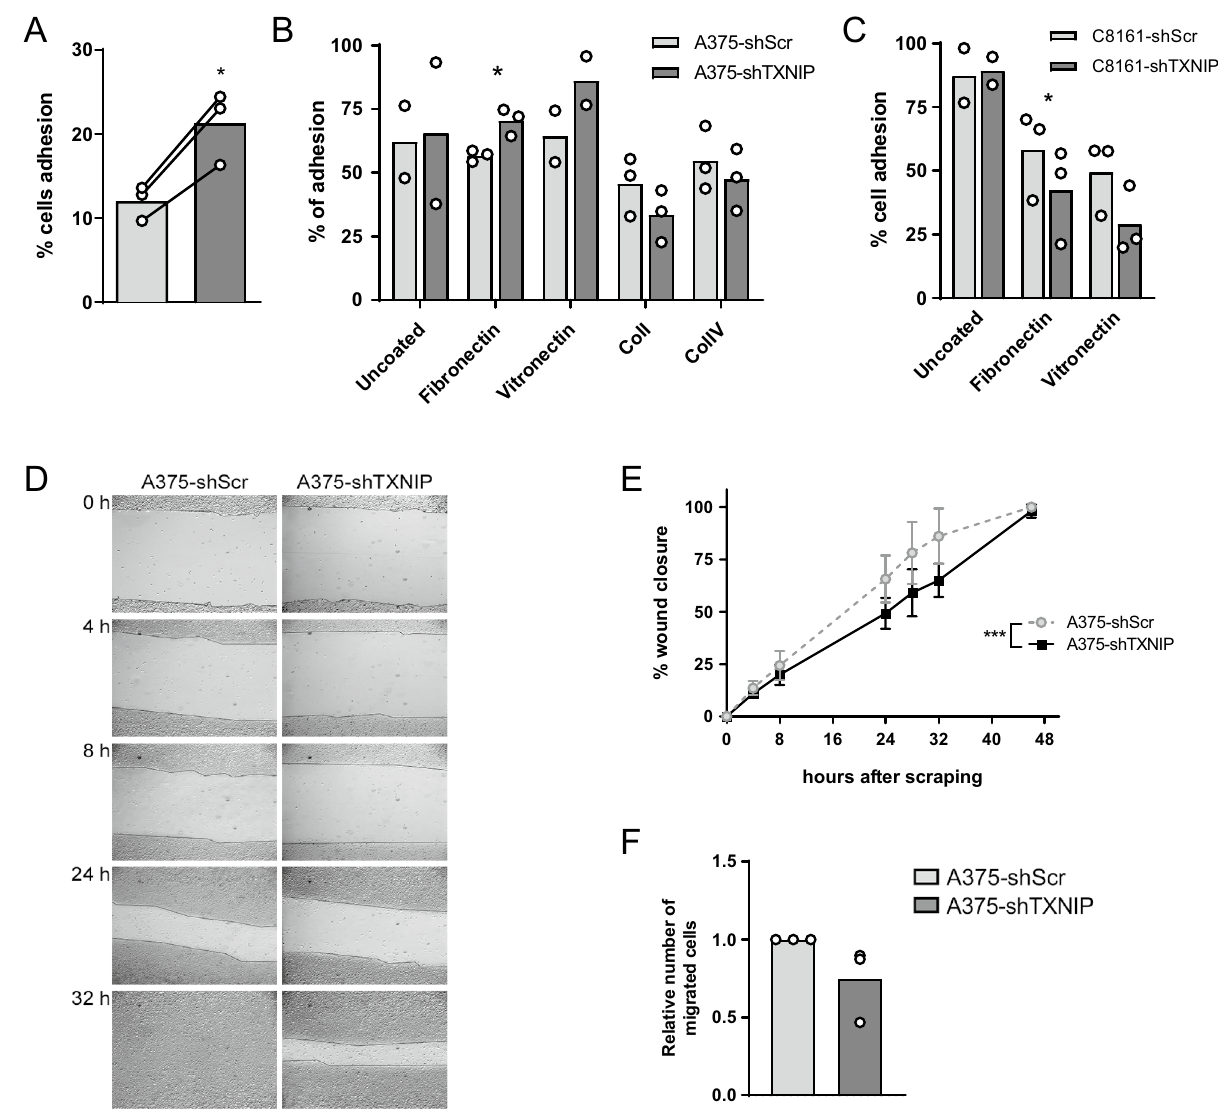
Figure 5. TXNIP silencing affects melanoma cell adhesion and migration. (A) Trypsin resistance assays of A375-shScr and A375-shTXNIP cells. Each open circle represents one independent experiment with biological triplicates (n = 3). Columns are means of three independent experiments (N = 3). Statistics: paired Student’s t-test. (B) Adhesion assays of A375-shScr and A375-shTXNIP cells on various ECM protein coatings, as indicated. Each open circle represents one independent experiment with biological triplicates (n = 3). Except for Uncoated and Vitronectin treatments (N = 2), three independent experiments were performed (N = 3). Columns are means of two to three independent experiments. Statistics: paired Student’s t-test. (C) Adhesion assays of C8161-shScr and C8161-shTXNIP cells on various ECM protein coatings, as indicated. Each open circle represents one independent experiment with biological triplicates (n = 3). Columns are means of two to three independent experiments (N = 3). Statistics: paired Student’s t-test. (D) A375-shScr and A375-shTXNIP cell monolayer scraping assays. The quantification of three independent scraping assays (N = 3) is shown in (E) Grey circles/dotted line and black squares/plain line represent the means of three independent experiments (N = 3); each independent experiment included biological triplicates (n = 3). Data are expressed as means ± SD. Statistics: two-way ANOVA (F) Number of A375-shScr and A375-shTXNIP cells migrating through a porous membrane in a transwell assay, 6 h after plating. Each open circle represents one independent experiment with biological triplicates (n = 3). Columns are means of three independent experiments (N = 3). All panels *, P < 0.05; **, P <